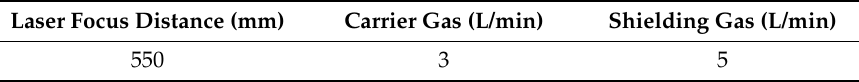
Table 2. Common process parameters.